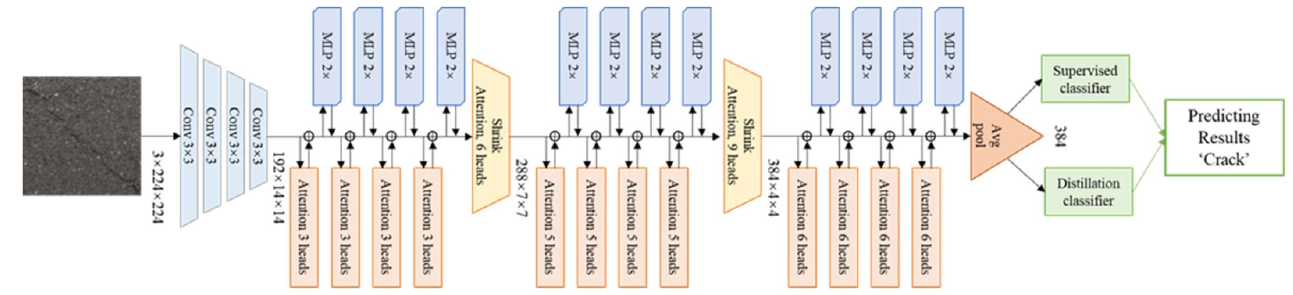
Figure 7. The architecture of the LeViT-192.